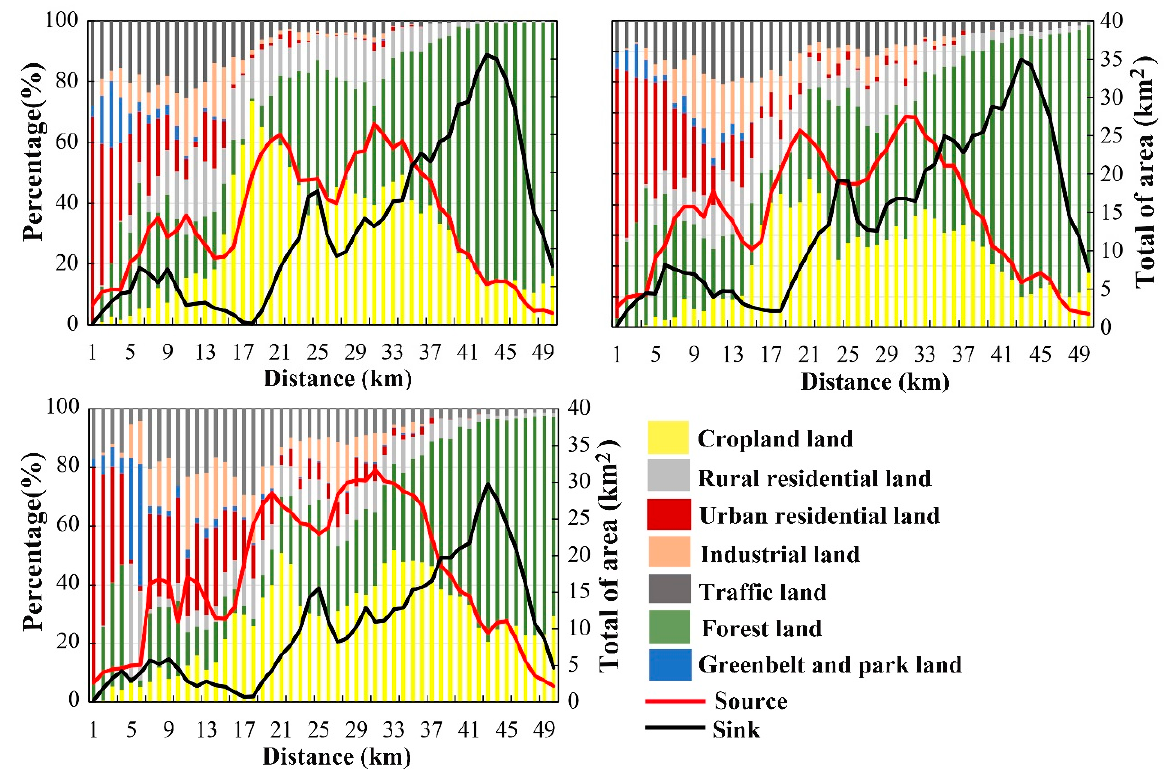
Figure 5. Spatio-temporal characteristics of landscape types.